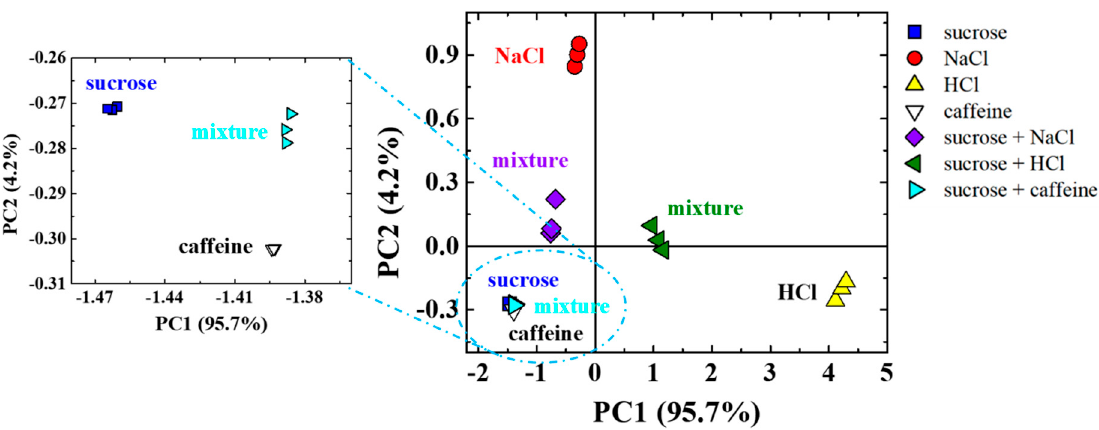
Figure 5. PCA score plots of the capacitance data at 1 kHz in three independent sets of measurements obtained using a microfluidic e-tongue to evaluate sucrose and their mixtures with NaCl, HCl, and caffeine obtained under flow (1 mL/h) inside a Y-shaped polydimethylsiloxane (PDMS) microchannel with a passive mixer.